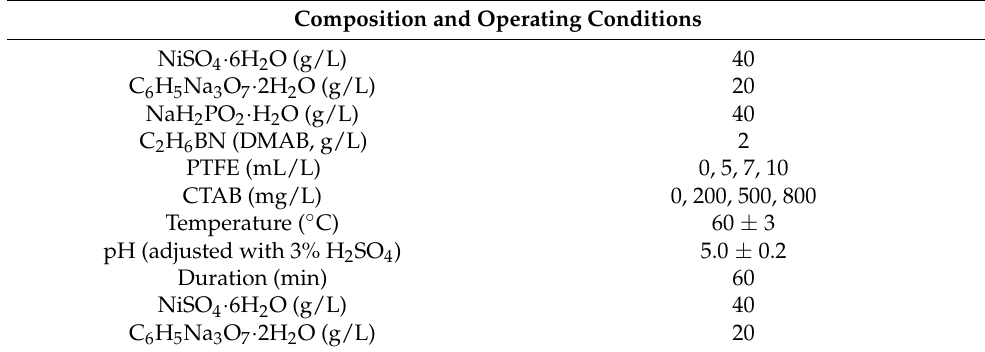
Table 1. Plating bath conditions. An example of a plated sample can be seen in the table. Composition and Operating